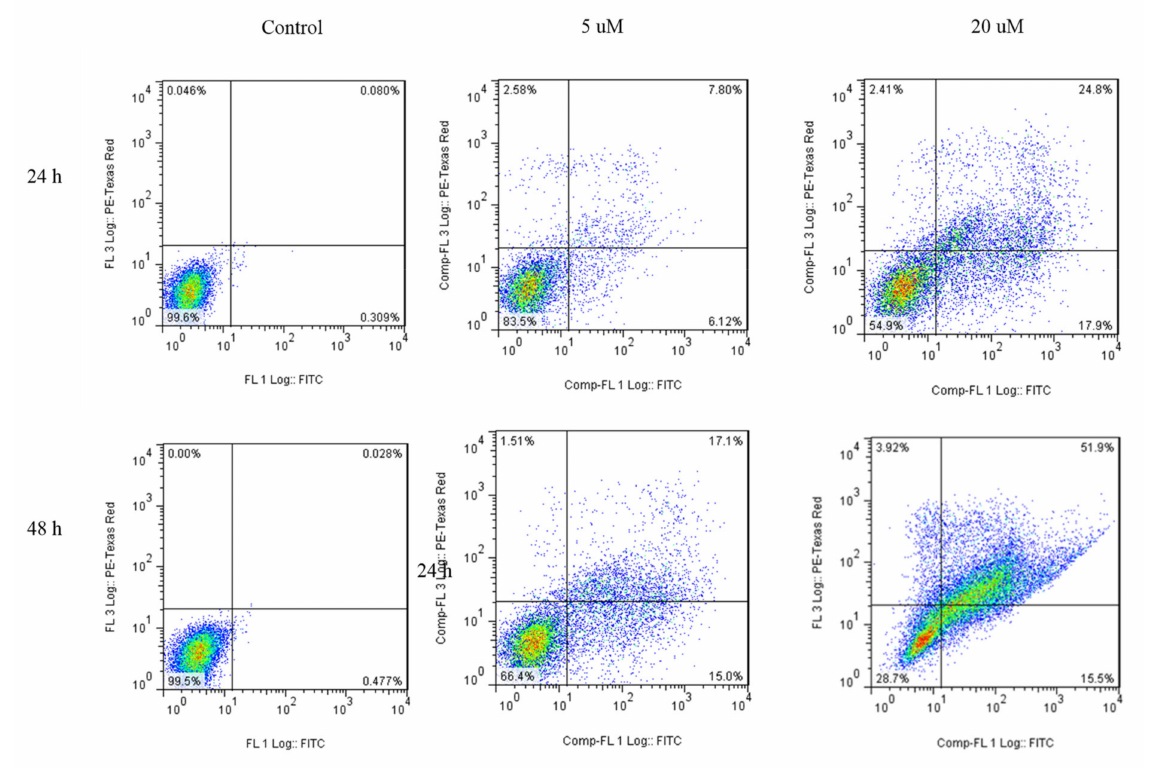
Figure 12. HepG2 cells inoculated with 0 µ M, 5 µ M, or 20 µ M of complex 1 for 24 h or 48 h.